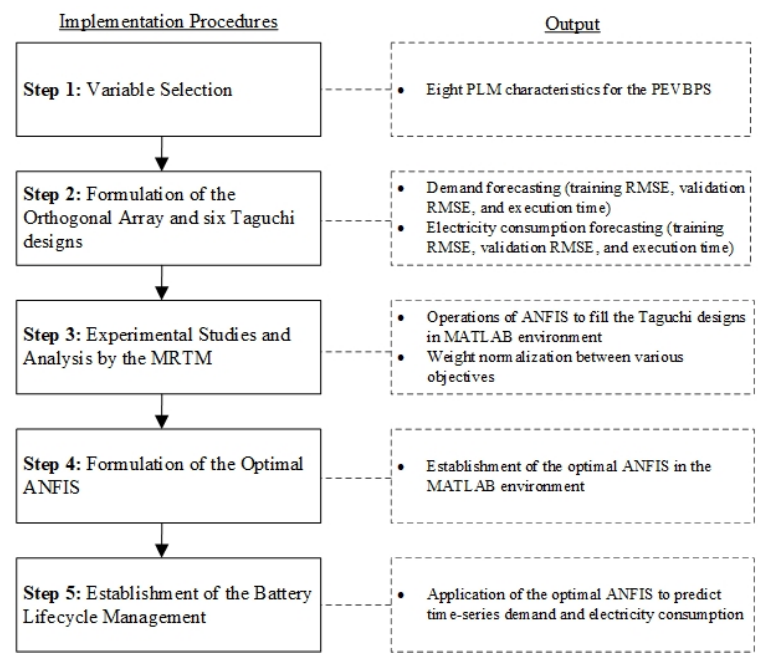
Figure 4. Implementation roadmap of the fuzzy-based battery life-cycle prediction framework (FBLPF).